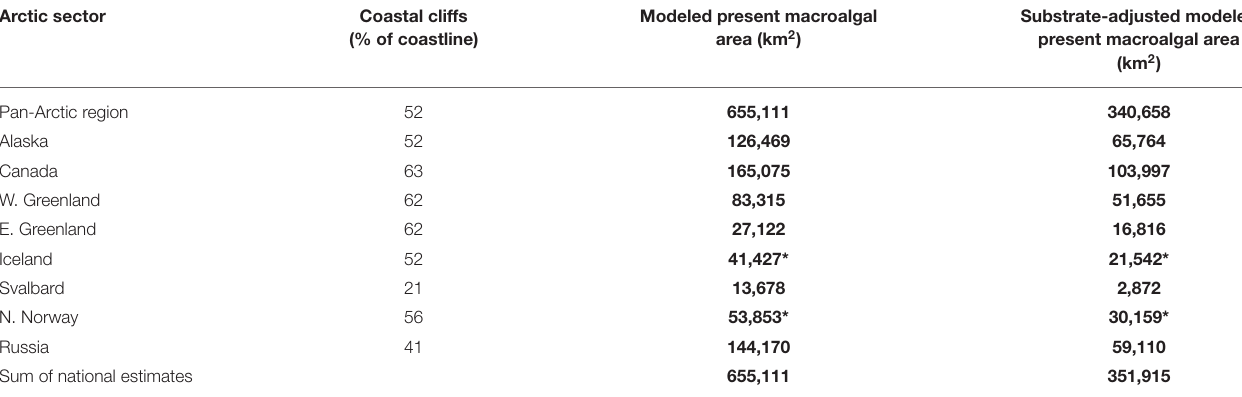
TABLE 4 | Information on substrate conditions for Arctic coastlines and potential total distribution area of brown macroalgae, and distribution areas adjusted by substrate conditions. Arctic